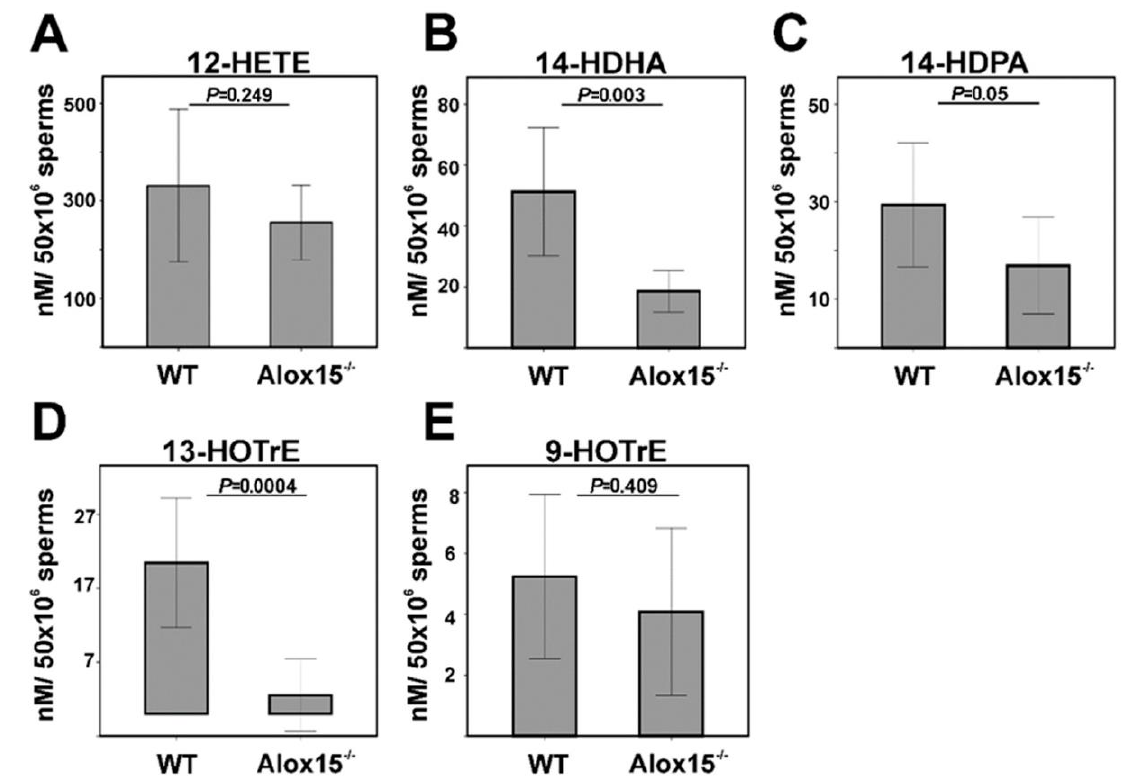
Figure 4. Quantification of Alox15 products in the lipid extract of sperm prepared from wild-type mice and Alox15 − / − animals. Epididymal cauda sperm were prepared from wild-type mice and Alox15-deficient animals, their total lipids were extracted, hydrolyzed under alkaline conditions, and selected hydroxy PUFAs were quantified by LC-MS/MS (see “Materials and Methods”). ( A ) 12-hydroxy arachidonic acid (12-HETE), ( B ) 14-hydroxy docosahexaenoic acid (14-HDHA), ( C ) 14-hydroxy-docosapentaenoic acid (14-HDPA), ( D ) 13-hydroxy alpha linolenic acid (13-HOTrE), and ( E ) 9-hydroxy alpha linoleic (9-HOTrE). The degree of significance ( p -values) is given above the columns. Significances were calculated using Student’s t -test. N = 8 animals from each genotype were analyzed and p -values < 0.05 were considered statistically significant.